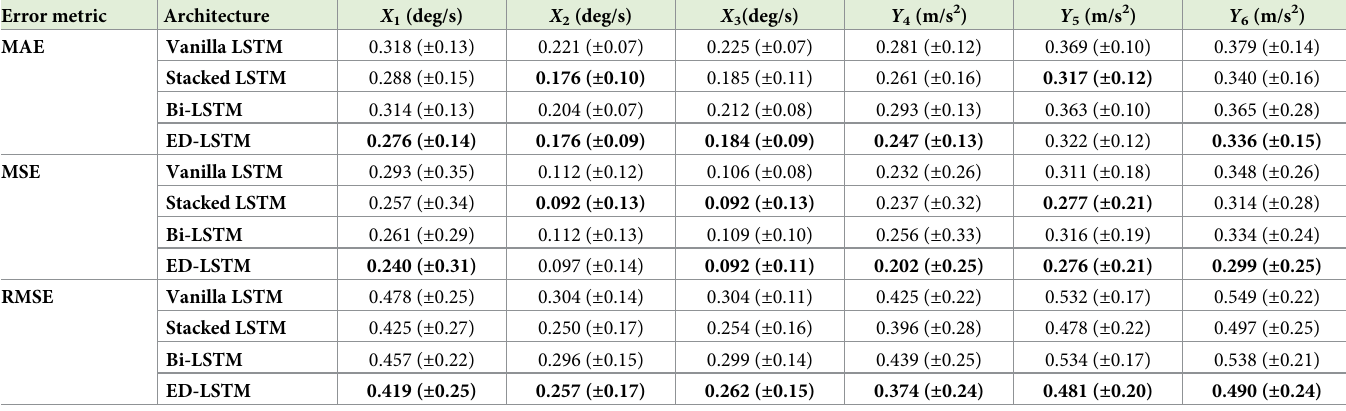
Table 3. Leave-one-out cross validation test error based on the MAE, MSE and the RMSE at the PWS and 5km.h -1 combined. Error metric